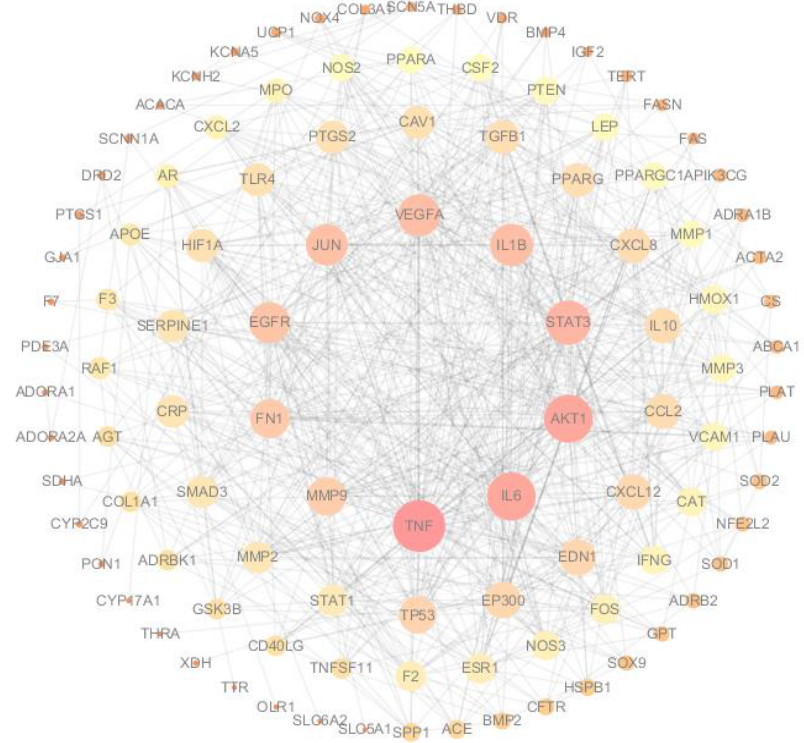
Figure 2. PPI network of common compound – disease targets. The size and color of nodes indicate the magnitude of the degree. A larger size of a node means a larger degree.